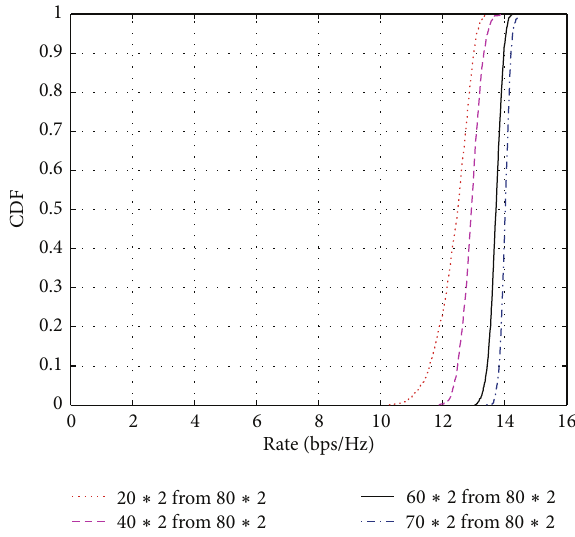
Figure 2: Impact of MIMO system size on CDF.